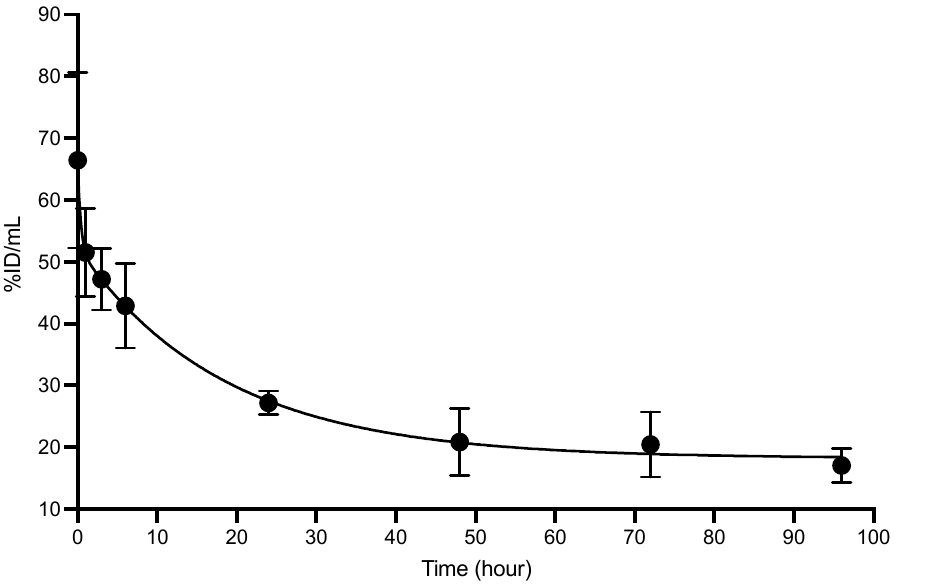
Figure 6. In vivo epitope-specific imaging and biodistribution. ( A ) CD-1 athymic nude mice bearing EGFR-positive DLD-1 (left flank) and HT-29 (right flank) were pre-dosed with excess (50-fold of the imaging dose) of nimotuzumab 24 h prior to administration of 89 Zr-matuzumab followed by microPET/CT imaging. ( B ) Ex vivo biodistribution of the mice at 120 h post-injection. 89 Zr-matuzumab exhibited biphasic clearance with fast distribution clearance of t ½ α of 3.8 ± 0.27 h and a slow clearance of t ½ β of 165 ± 14 h (Figure 7, Table 1).